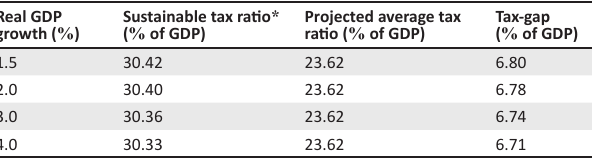
FIGURE 6: Tax-gap indicator (historical). TABLE 2: Sustainable tax ratio to keep debt below 25 % of GDP by 2018. Real GDP Sustainable tax ratio * growth ( % ) ( % of GDP)